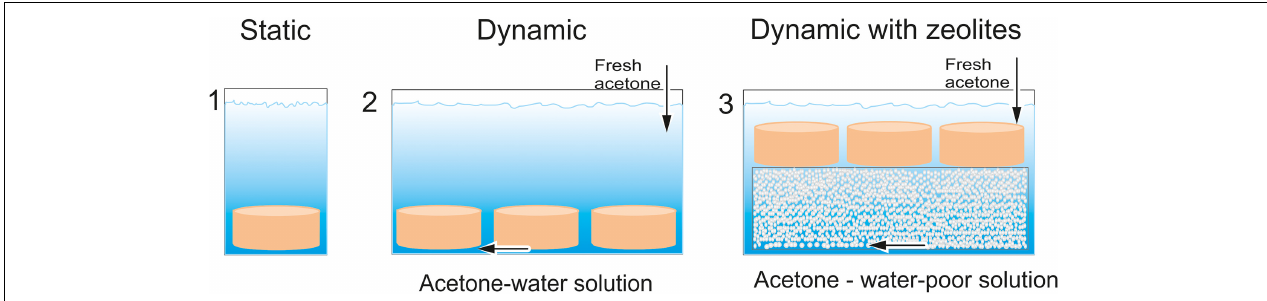
FIGURE 2 | Three different setups for solvent exchange: (1) static method with placing samples in acetone bath; (2) Dynamic solvent exchange by use of pump; (3) Dynamic solvent exchange with additional use of zeolites as adsorptive.